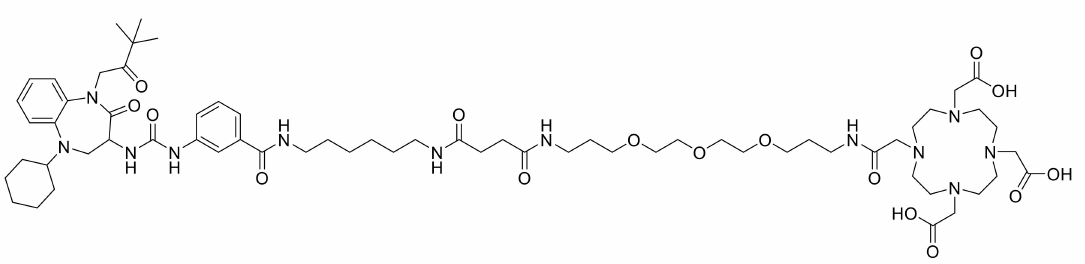
Figure 14. Chemical structure of IP-001